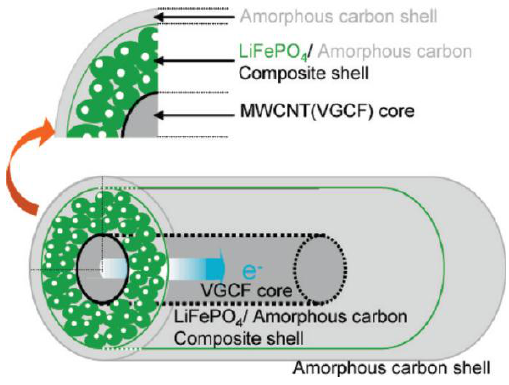
Figure 3. Model image of the triaxial nanowire with a vapor-grown carbon fiber (VGCF) core column and the two layer shells: an outer shell of amorphous carbon and an inner composite shell of LiFePO 4 and amorphous carbon. Reproduced with permission from [53]. Copyright American Physical Society, 2010.